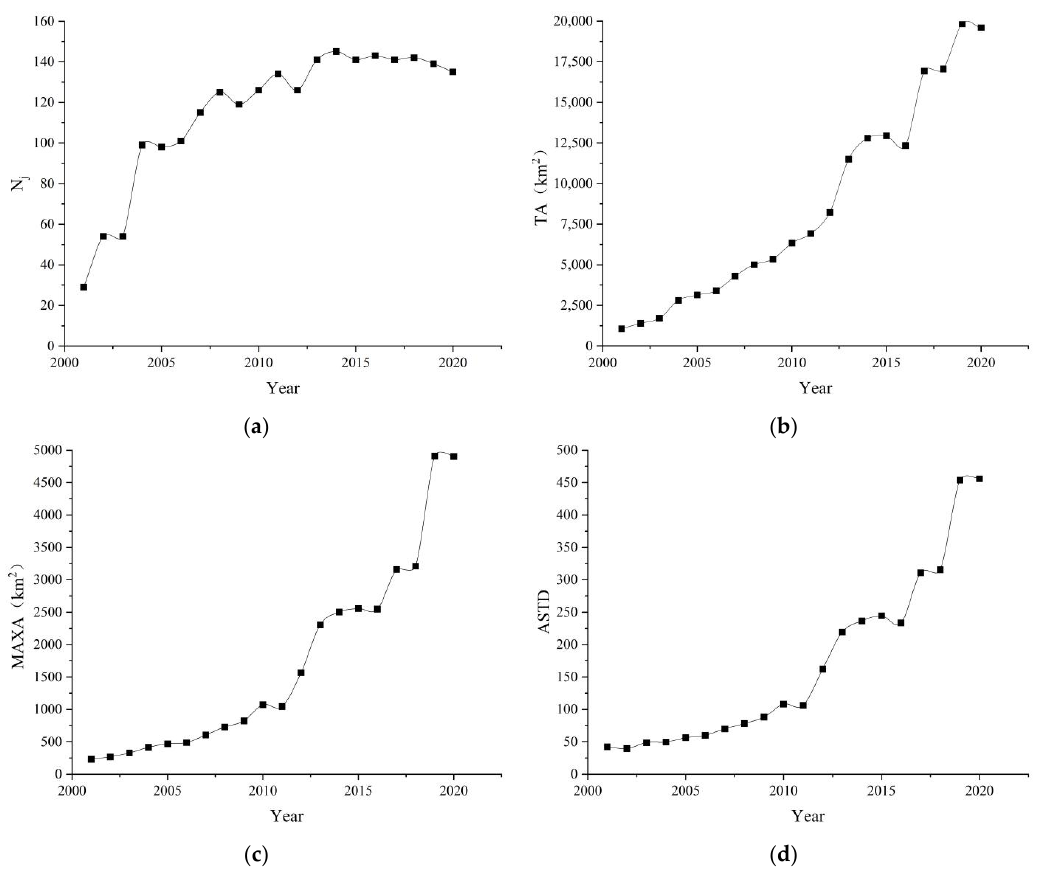
Figure 11. Henan attribute information for the level 1 connected components: ( a ) number of connected components, ( b ) total area, ( c ) maximum area, and ( d ) area standard deviation.